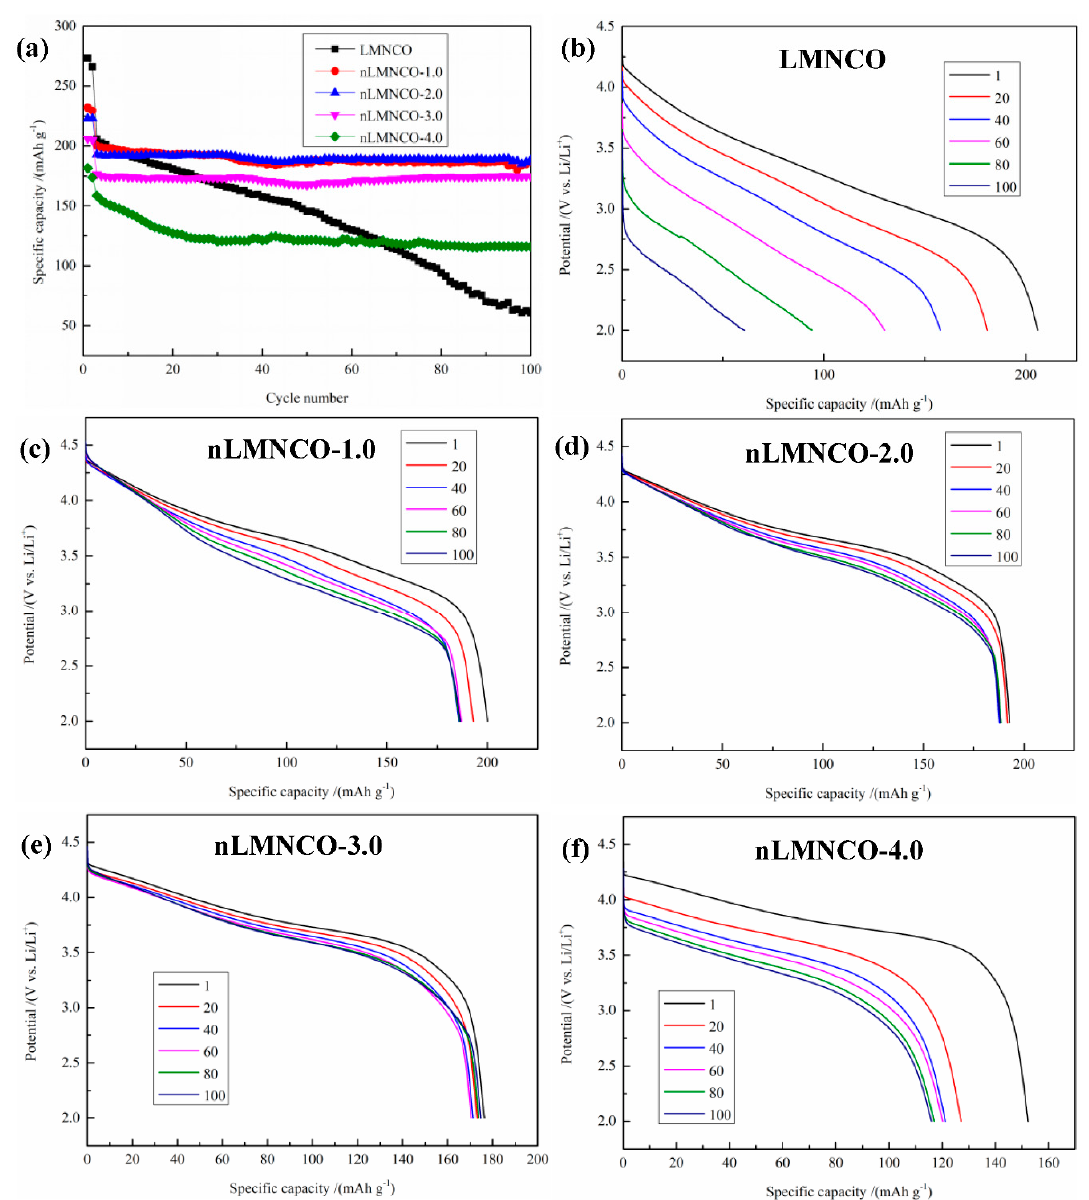
Figure 8. Performance of the LMNCO, nLMNCO-1.0, nLMNCO-2.0, nLMNCO-3.0, and nLMNCO- 4.0 cathode materials at 0.5 C: ( a ) long cycle performance and ( b – f ) discharge capacity curves with different turn numbers.